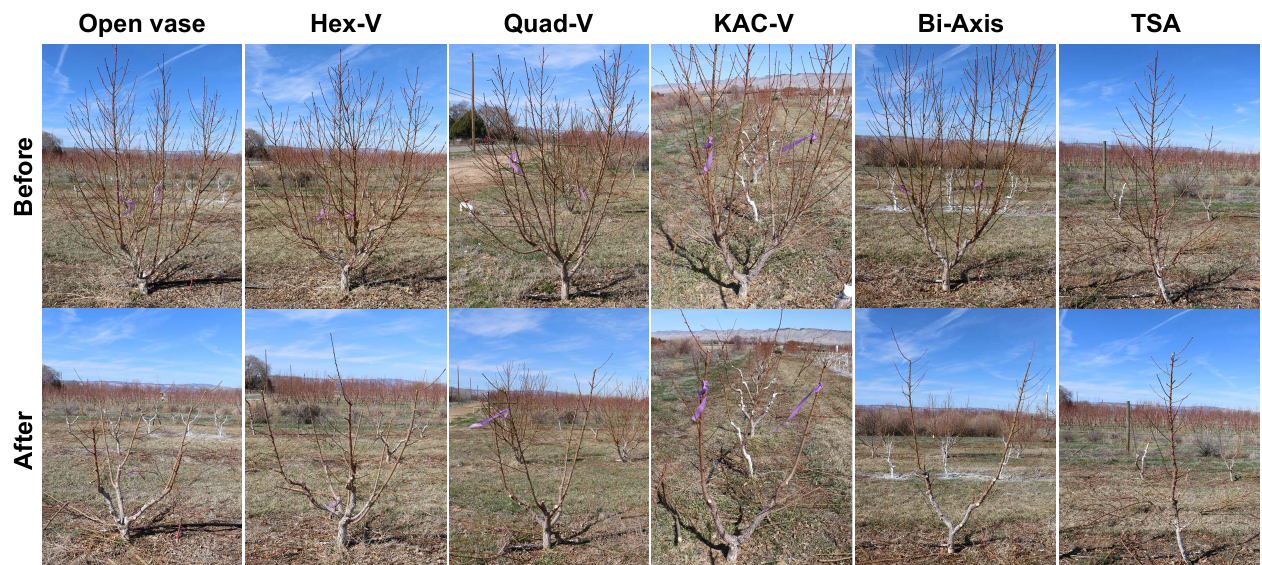
Figure 5. Orchard appearance of six canopy architectures of the most widely used training systems in ‘O’Henry’ peach trees (grafted on ‘Krymsk ® 86 ′ rootstock) before and after dormant pruning following the 3rd leaf from planting at the Colorado State University’s Experimental Orchard at Western Colorado Research Center—Orchard Mesa (WCRC-OM) located in Grand Junction, CO, USA.